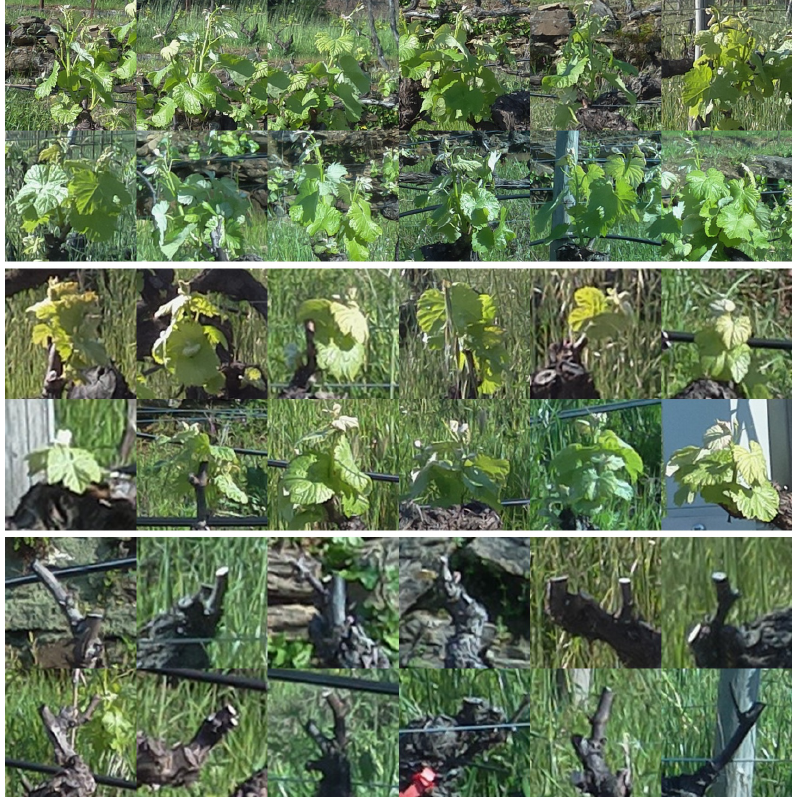
Figure 6. Grapevine’ shoots images that compose the training dataset: ( Top ) shoots whose size surpasses 10 cm; ( Middle ) shoots whose size is lesser than 10 cm; ( Bottom ) still no shoots